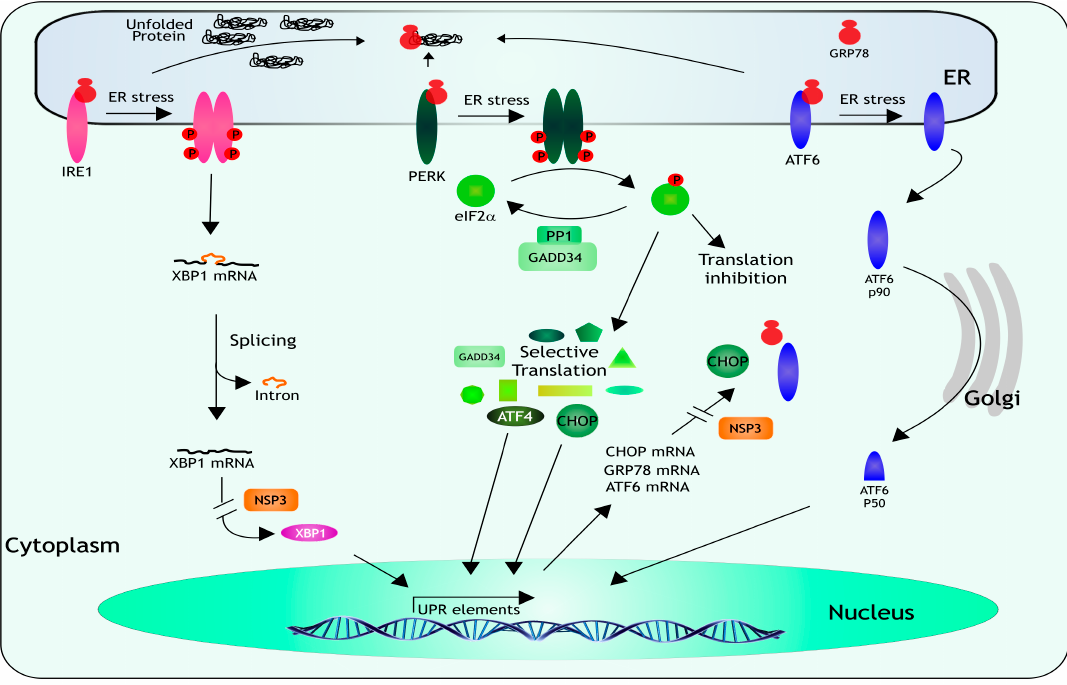
Figure 3. The unfolded protein response. When misfolded proteins accumulate in the ER lumen, GRP78 releases three ER-resident transmembrane proteins, which act as stress sensors: IRE1, PERK, and ATF6. IRE1 has an endonuclease activity that upon dimerization and autophosphorylation mediates the removal of an intron from XBP1 mRNA. The spliced XBP1 encodes a factor that triggers the transcription of genes encoding proteins involved in ER stress-associated protein degradation. Upon activation, PERK phosphorylates eIF2 α , resulting in a global inhibition of protein synthesis, and in the selective translation of ATF4 and CHOP, which activate the transcription of several UPR-responsive genes encoding proteins that mitigate the ER-stress, like GADD34, a protein that interacts with PP1 to dephosphorylate eIF2 α , to recover protein